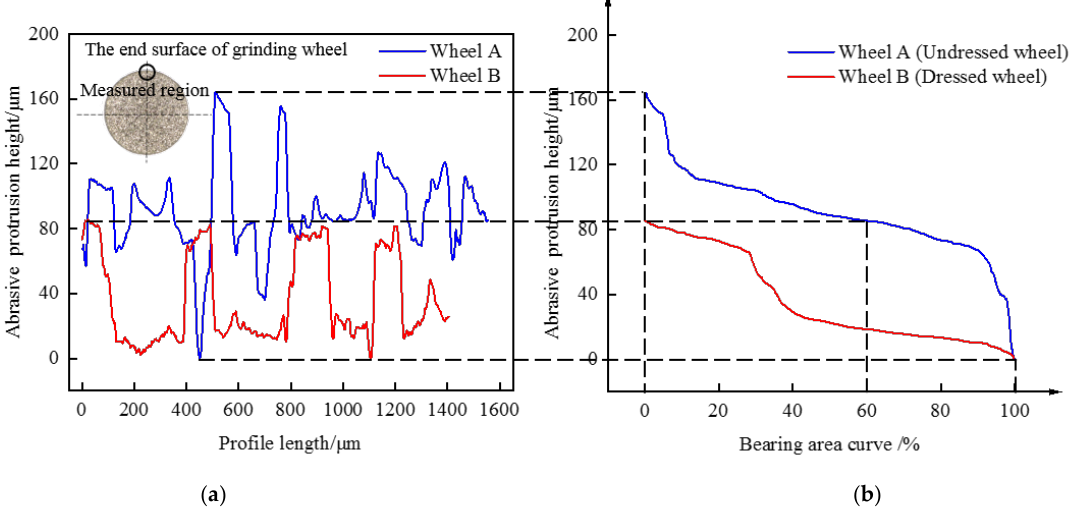
Figure 2. Comparison of abrasive grits morphology of grinding wheel A and B in the peripheral region, the schematic diagram of the end face abrasive grain selection area is shown in ( a ). ( a ) Profiles. ( b ) Bearing area curve based on line profile.